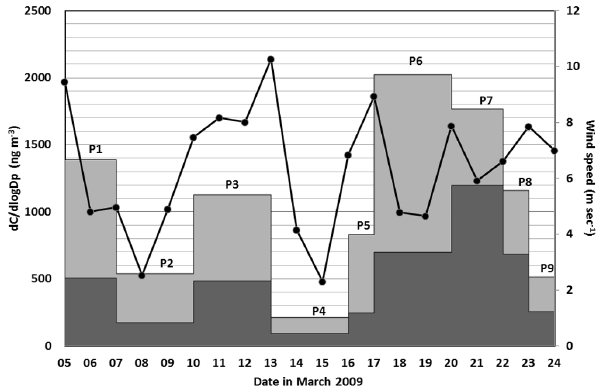
Fig. 2. Particle mass collected by the MOUDI during the different sampling periods (Px) in March 2009 shown for particles where D > 1 . 8µm (dark grey) and D < 1 . 8µm (light grey). The 24-h mean wind speed (ms − 1 ) at Long 16.5 ◦ W Lat 81.5 ◦ N is also shown as dots connected by a curve. The wind data are reanalysis data from NCEP/DOE AMIP